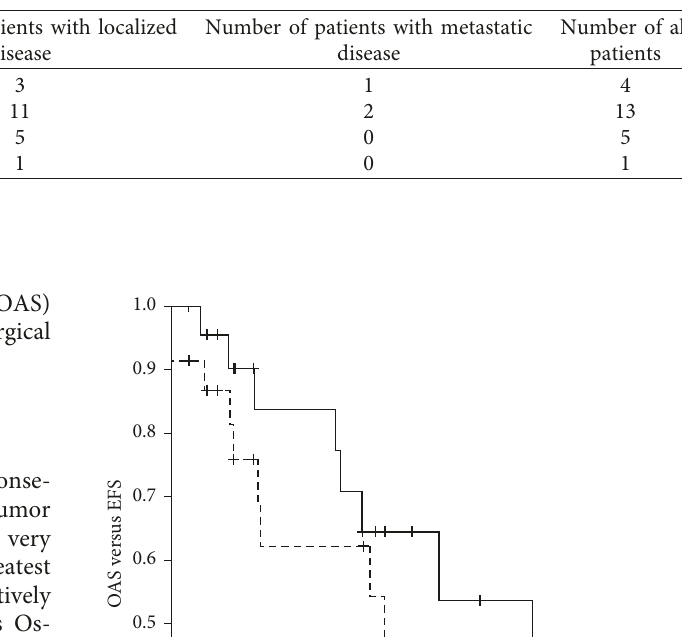
Table 4: Tumor response to preoperative chemotherapy.